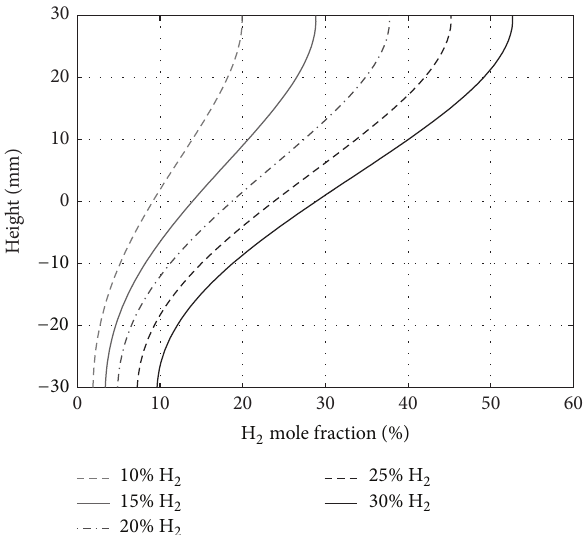
Figure 5: Local hydrogen content versus channel height after a waiting time of 3 s. The legend displays the overall hydrogen content of each mixture.